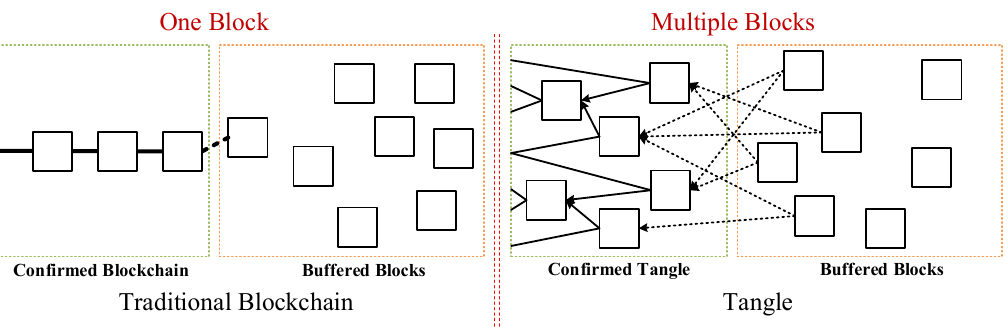
Figure 4. The difference between a traditional blockchain and Tangle.